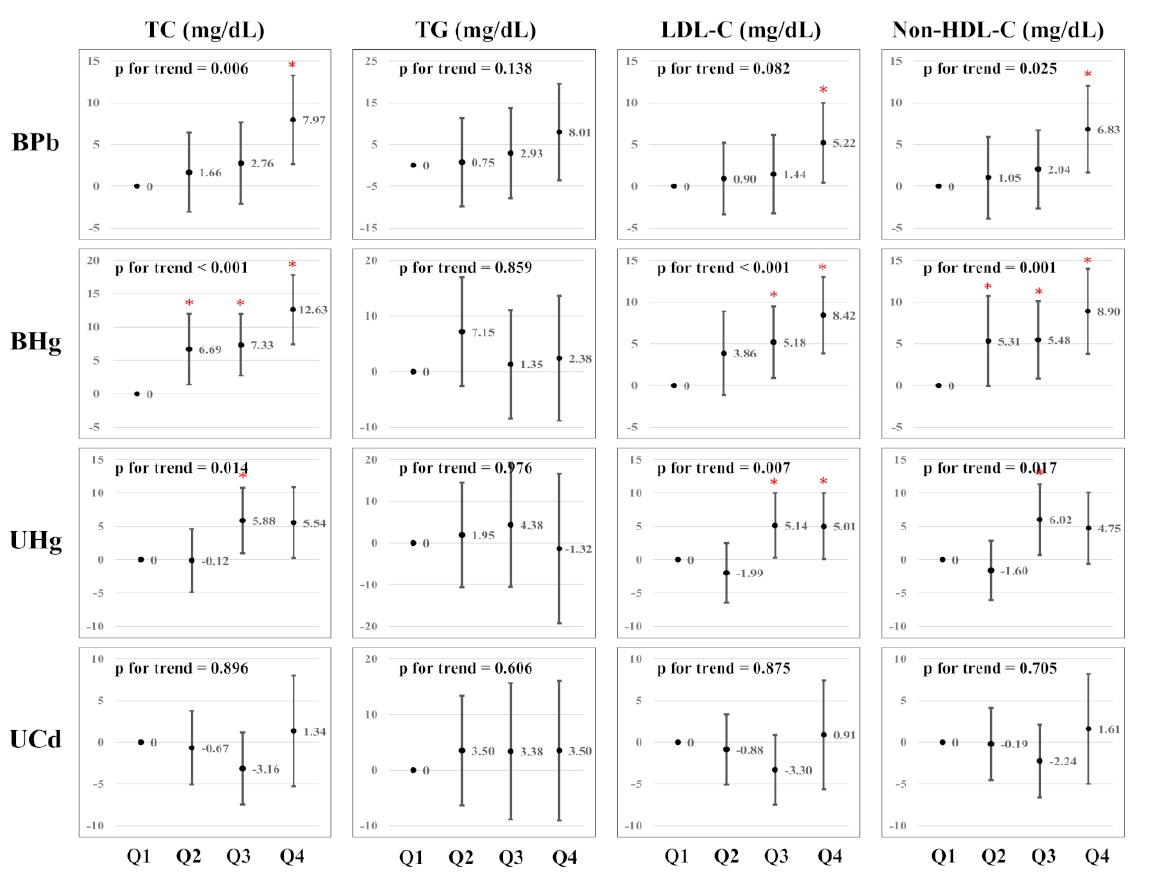
Figure 2. Multiple linear regression analysis of serum lipid profile by heavy metal concentrations ( n = 2591). Asterisks (*) indicate significance level